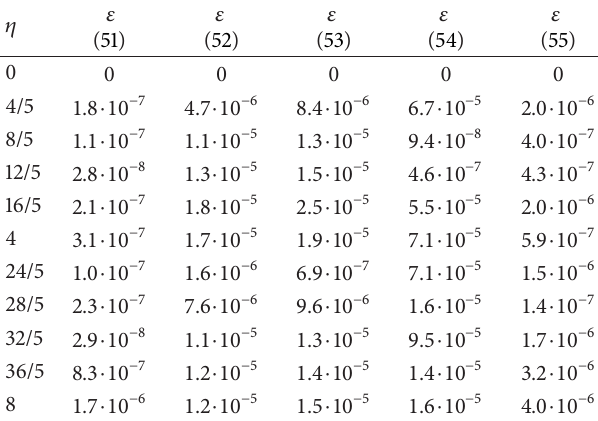
Table 7: Comparison of the first-order approximate solution 𝑓 obtained by OHAM with numerical results.